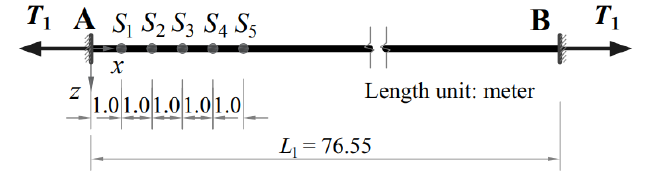
Figure 8. Five sensor locations on Cable 1.